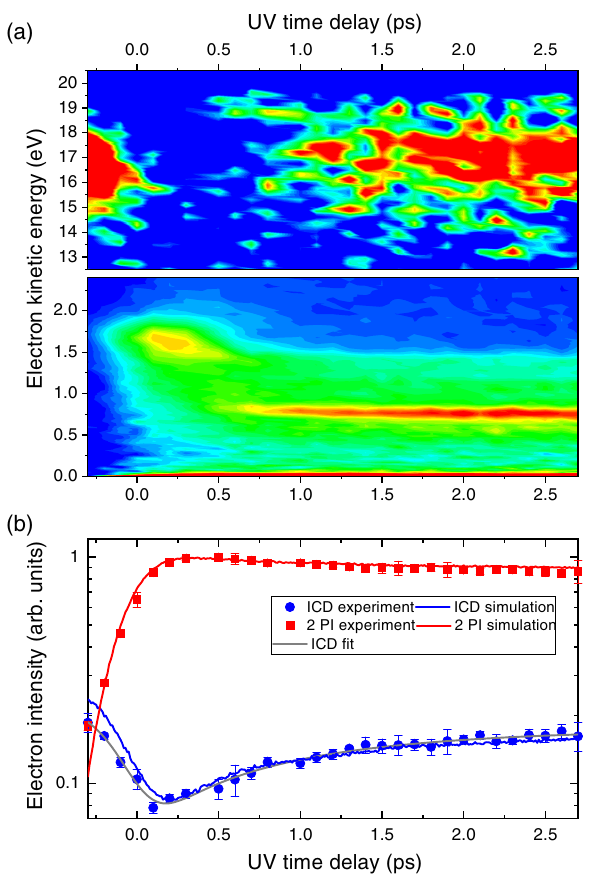
FIG. 2. (a) Time-resolved electron kinetic energy distributions of resonantly excited He droplets centered around the ICD peak (top) and the two-photon ionization (2PI) signal (bottom). (b) Projection of the intensity of the ICD peak (blue circles) and the 2PI signal (red squares) as a function of XUV-UV pump- probe delay. The experimental data are fitted with an exponential decay function convoluted with a cross correlation function (gray line). The red and blue lines show the results of a MC simulation (see the text for details). The droplet size is 76 000 atoms, and the excitation photon energy is 21.6